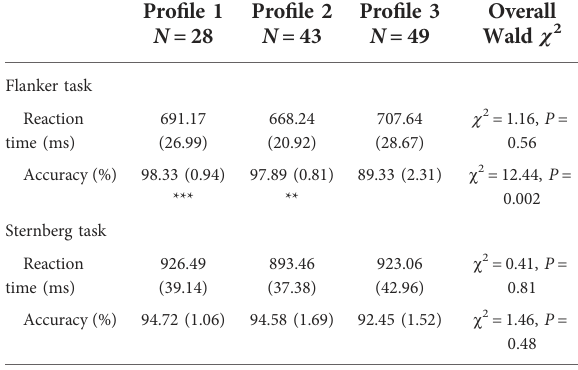
TABLE 4 Mean of physical fi tness across test sample ( N =120): executive